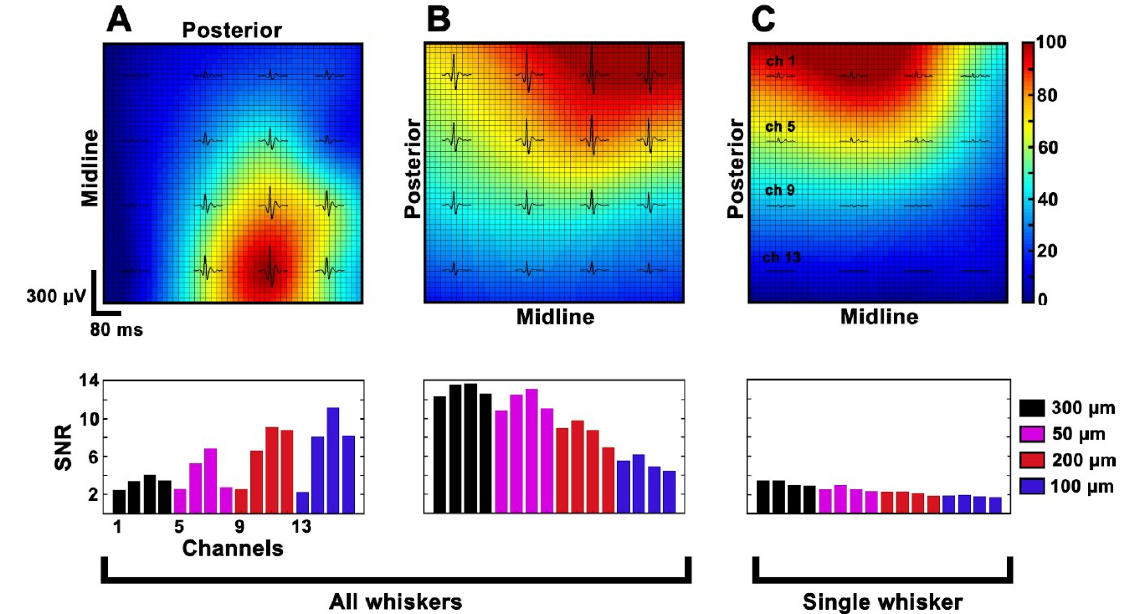
Figure 9. Representative interpolated maps of the averaged SEPs, first row recorded in different positions (A-B) or in the same position but stimulating all and single whiskers (B-C). The colormap reflects the SEP sizes normalized in the range [0, 100] independently for each experimental condition. The second row reports the corresponding SNR histograms, which show how the same electrode can take high or low values depending on its position or intensity of the signal.